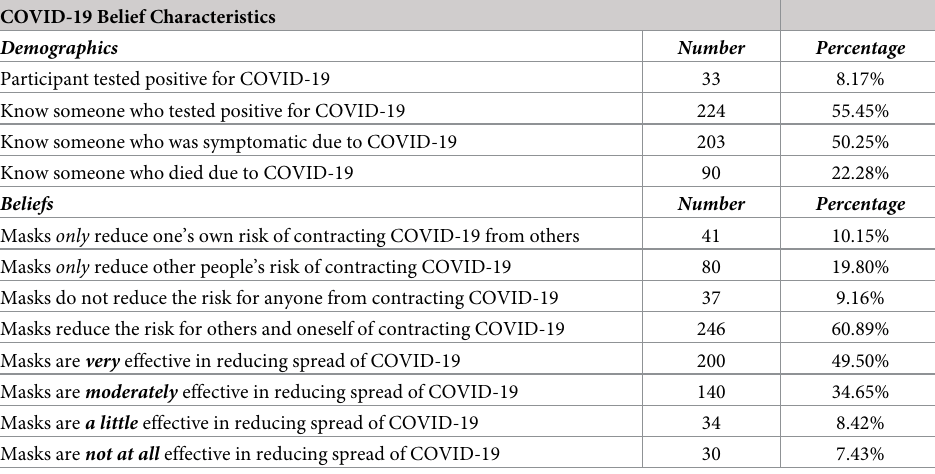
Table 3. COVID-19 Belief Characteristics Demographics Number Percentage Participant tested positive for COVID-19 33 8.17% Know someone who tested positive for COVID-19 224 55.45% Know someone who was symptomatic due to COVID-19 203 50.25% Know someone who died due to COVID-19 90 22.28% Beliefs Number Percentage Masks only reduce one’s own risk of contracting COVID-19 from others 41 10.15% Masks only reduce other people’s risk of contracting COVID-19 80 19.80% Masks do not reduce the risk for anyone from contracting COVID-19 37 9.16% Masks reduce the risk for others and oneself of contracting COVID-19 246 60.89% Masks are very effective in reducing spread of COVID-19 200 49.50% Masks are moderately effective in reducing spread of COVID-19 140 34.65% Masks are a little effective in reducing spread of COVID-19 34 8.42% Masks are not at all effective in reducing spread of COVID-19 30 7.43%